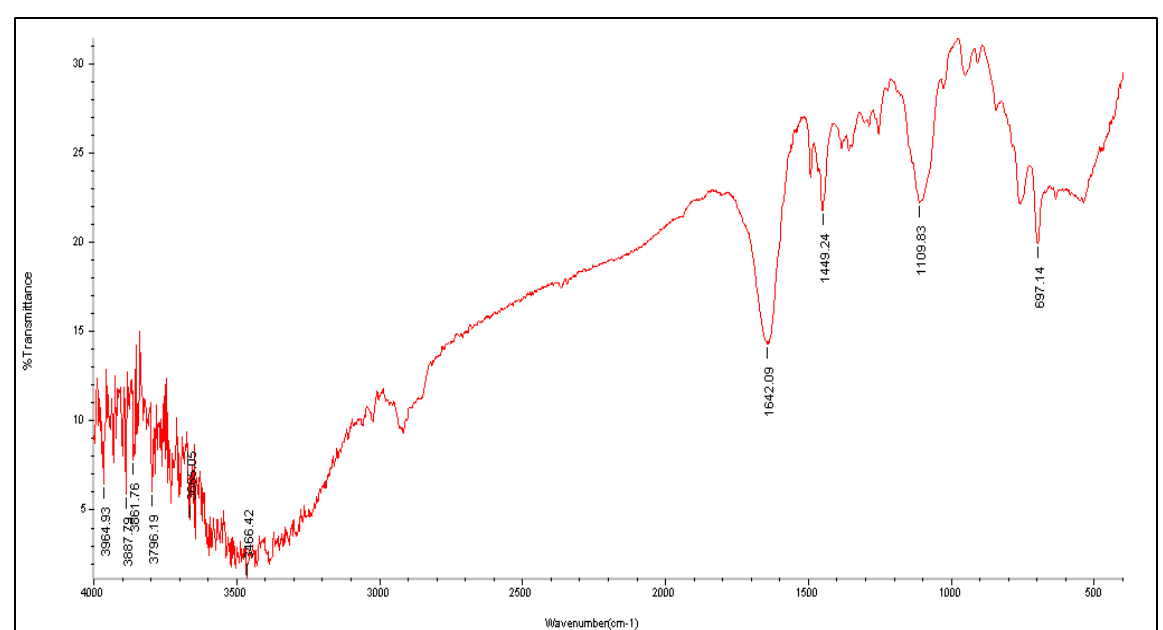
Figure 7. FTIR spectrum of blend powder best formula(F15a)